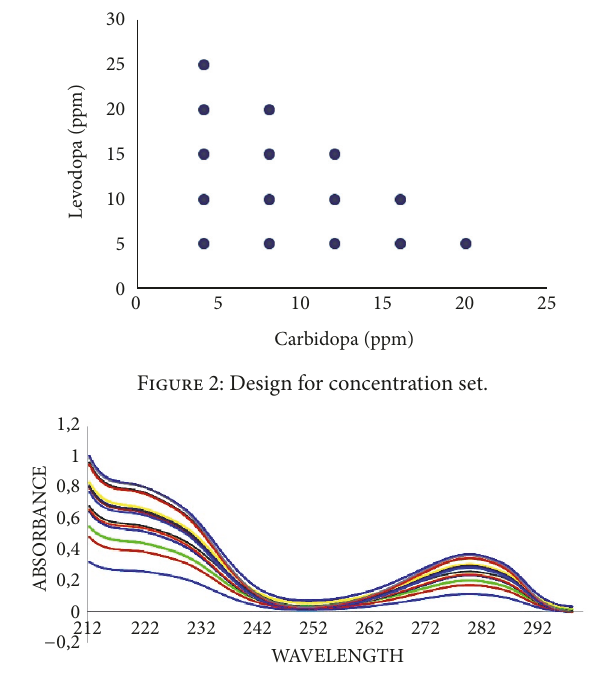
Figure 3: Absorption spectra of levodopa-carbidopa